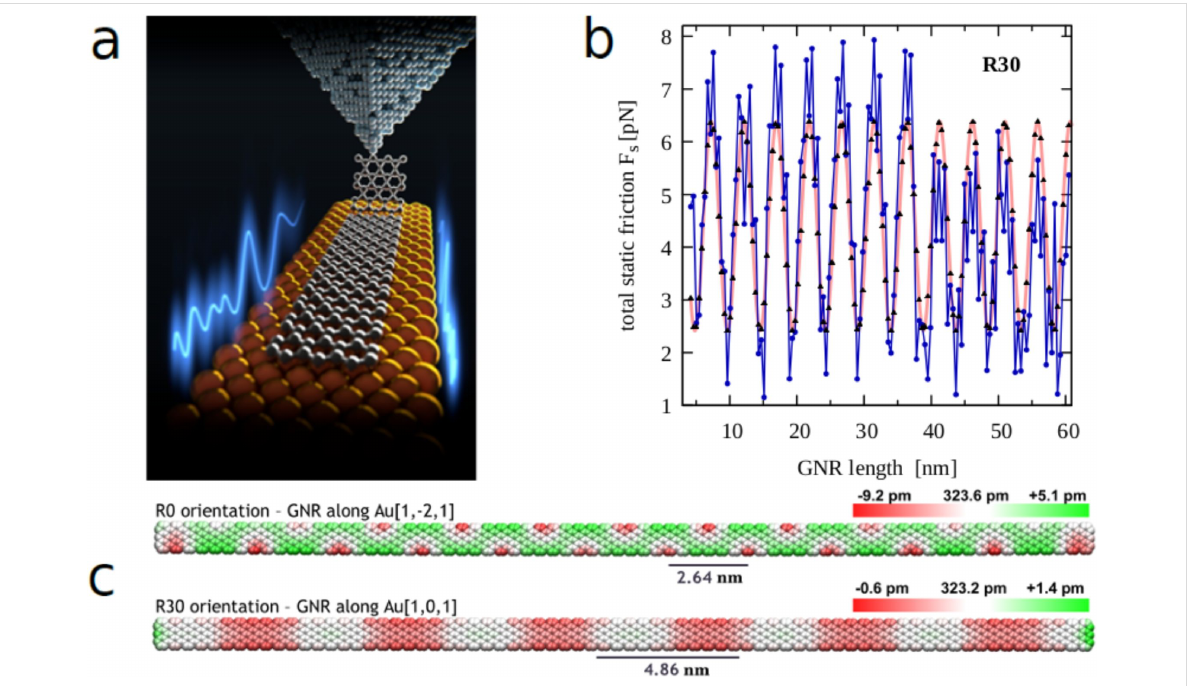
Figure 5: a) A graphene nanoribbon manipulated along a Au(111) surface. A probing tip lifts the GNR vertically, detaches it partially, and subse- quently moves it along the horizontal direction. A simultaneous measurement of the lateral forces shows that the incommensurability of the